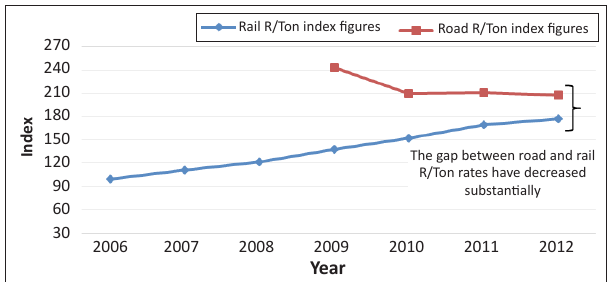
FIGURE 6: Road versus rail rand/ton rate index figures.